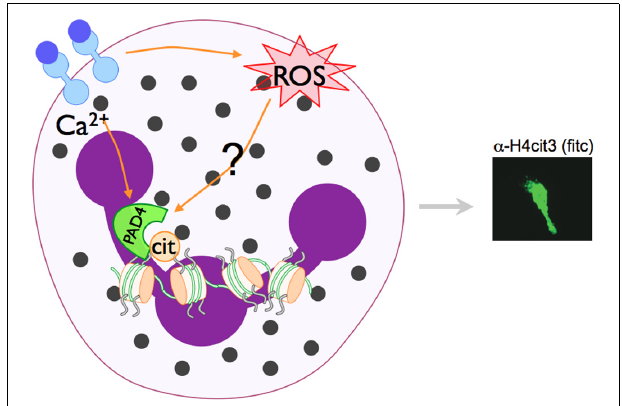
FIGURE 3 | Model of PAD4 activation in NET formation. Pathways that activate NET formation are less defined than phagocytic pathways, but are known to require NADPH oxidase activity and the activation of PAD4 and subsequent histone citrullination. PAD enzymes are Ca 2 + -dependent. Since PAD4-mediated histone citrullination is abrogated by the NADPH inhibitor apocyanin (Neeli etal., 2009), we speculate that NADPH regulated ROS generation and increase Ca 2 + levels may converge to activate PAD4 in